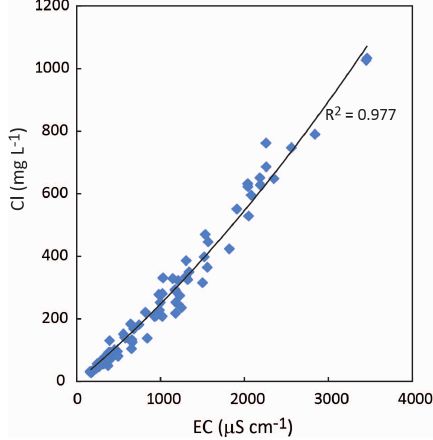
Fig. 2. Correlation between EC and Cl in the Barwon River. Data from Water Resources Data Warehouse (2012) and Cartwright et al.